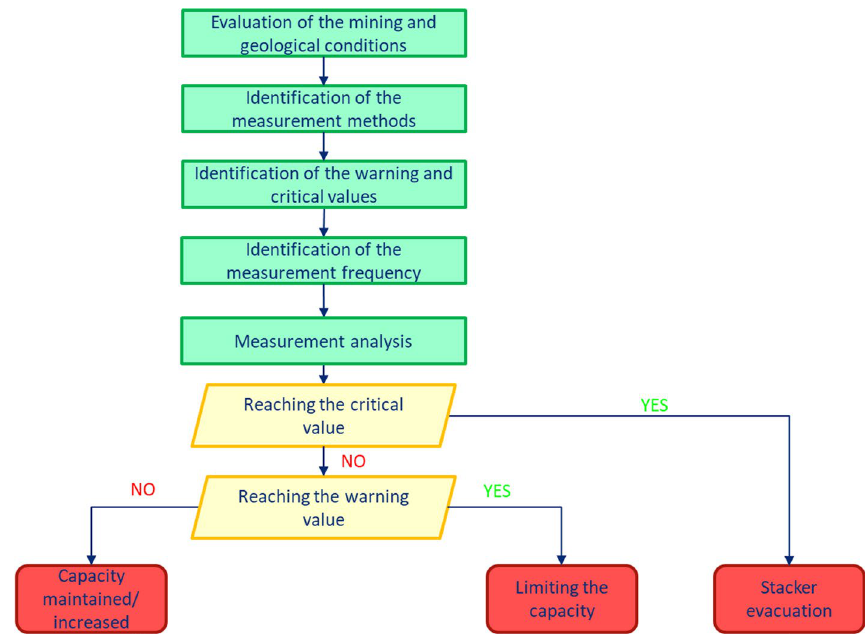
Fig. 9 The procedure of the observation method for the control of stacker capacity (Bąk and Bagińska